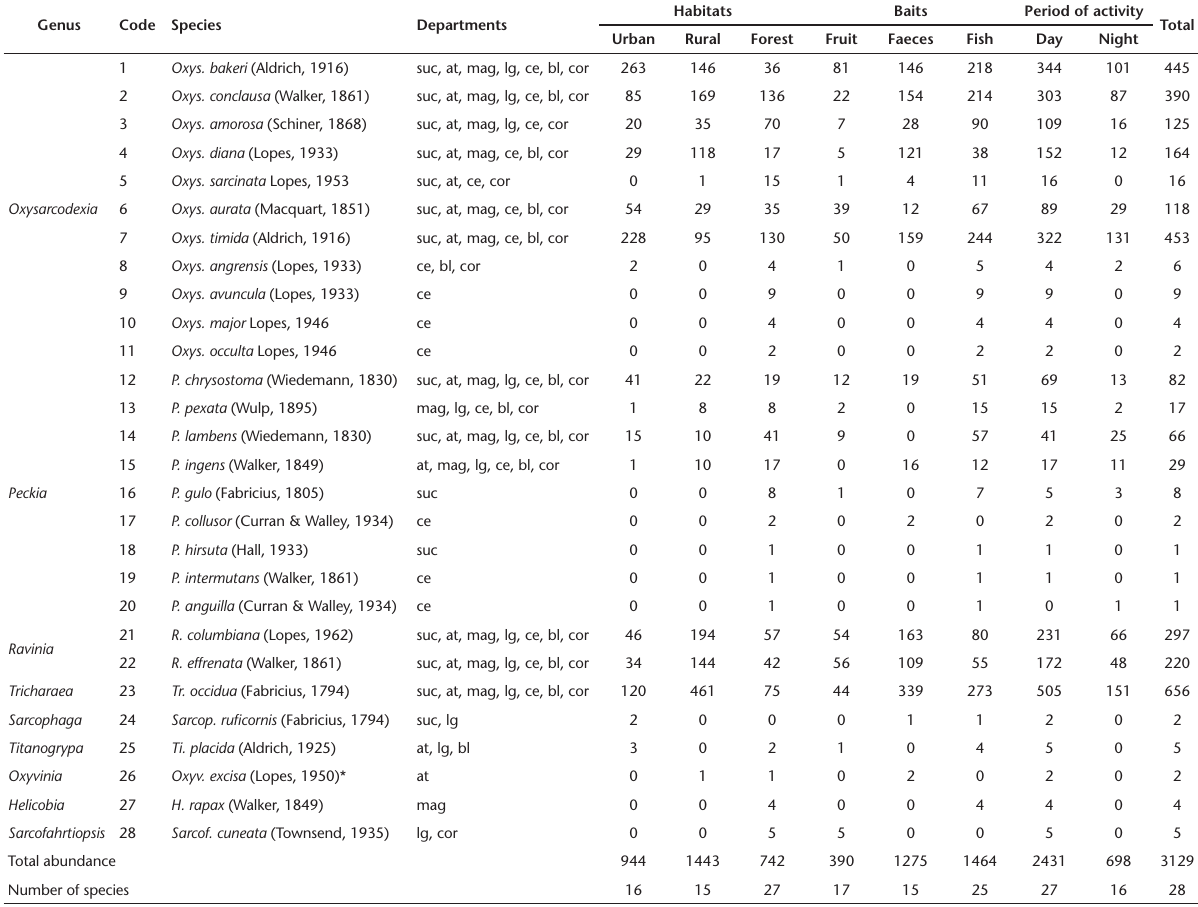
Table 2. Abundance of Sarcophaginae species (males) collected in the Colombian Guajira province (suc = Sucre, at = Atlántico, mag = Magdalena, lg = La Guajira, ce = Cesar, bl = Bolivar, cor = Cordoba). Species codes in first column are used in the Correspondence Analysis. Taxa are presented by genus, according to their abundance. New record for Colombia are indicated with *.